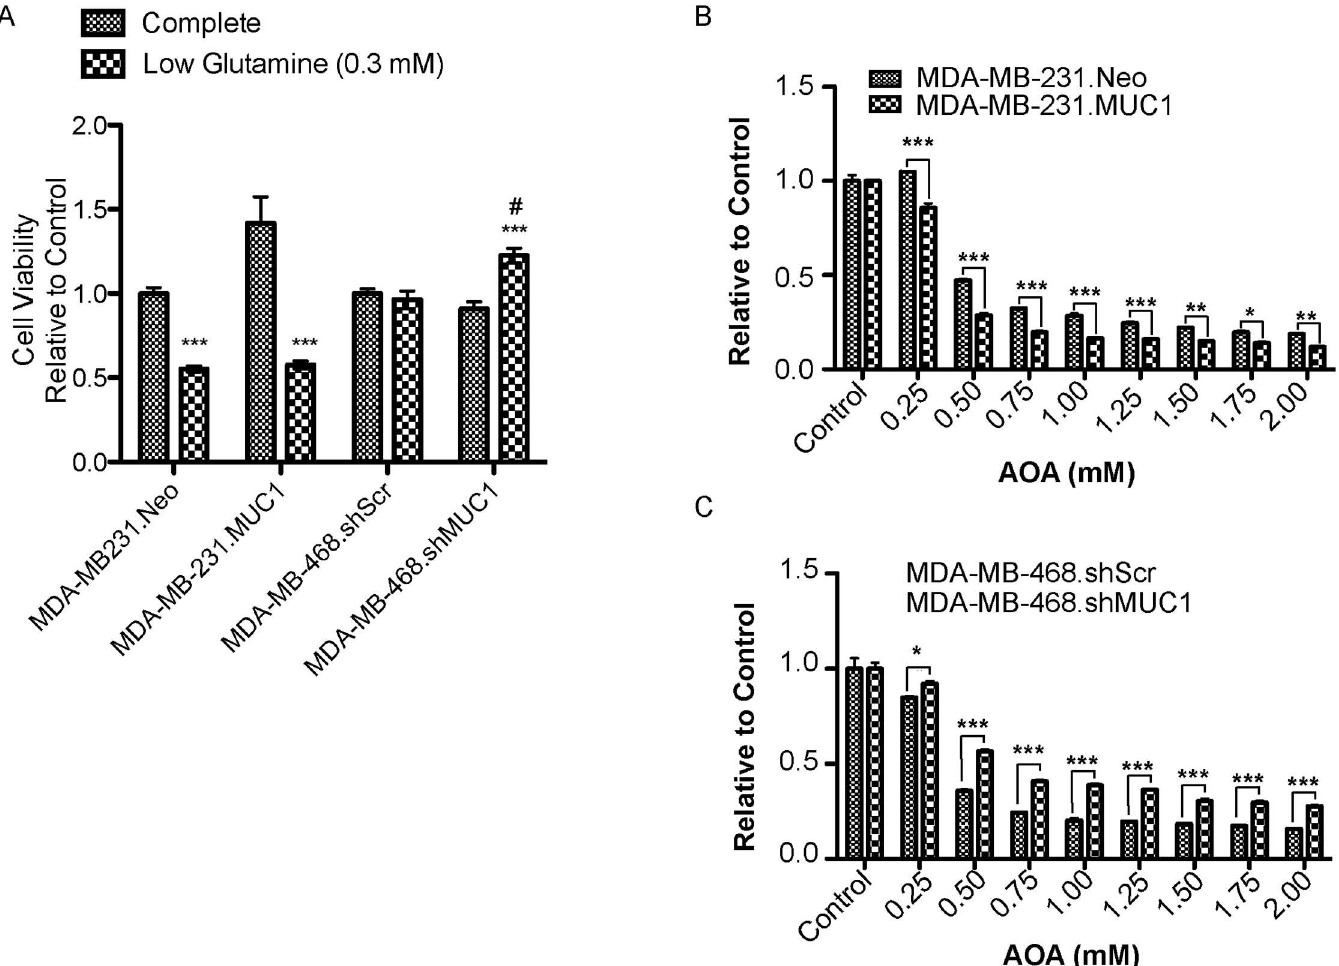
Fig 5. MUC1 alters glutamine dependency in TNBC. (A) Growth of TNBC cells (72 hours) incubatedwith completeor low glutamine(0.3 mM) cell culture media *** p < 0.001 vs. growth in complete media, # p < 0.05 vs. low glutamine(0.3mM) media. Cell viabilityof cells (72 hours) incubatedwith indicated concentration of AOA in completemedia (B) MDA-MB-231 (C) MDA-MB-468 * p < 0.05, ** p < 0.01, *** p <